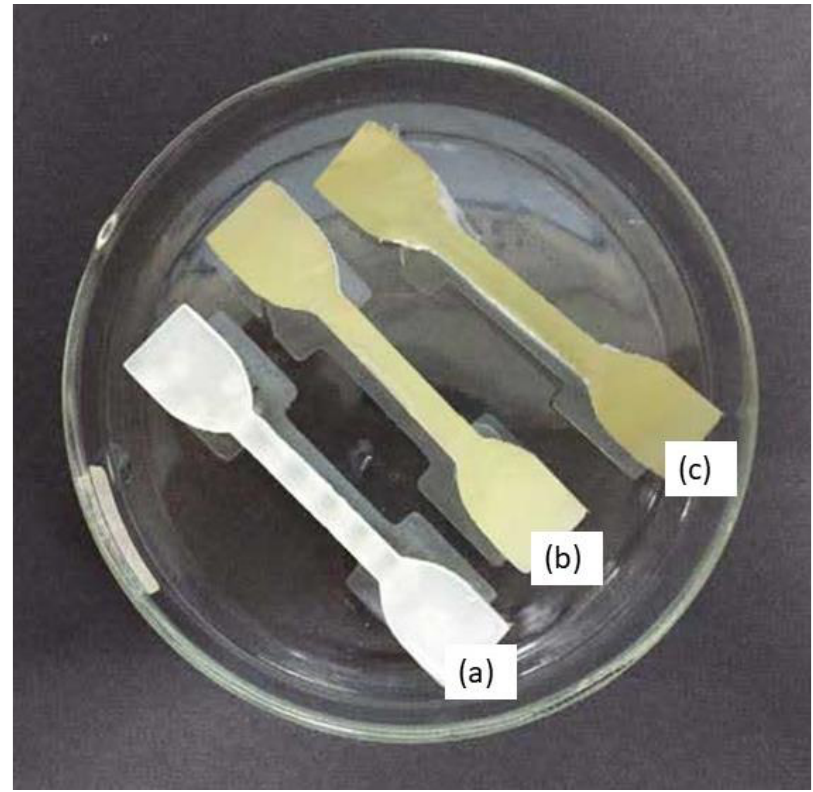
Figure 5. Dumbbell-shaped 3D-printed scaffold ( a ) 15% TPU + UHT; ( b ) 15% TPU+ UHT + 1% ϒ -Fe 2 O 3 ; ( c ) 15% TPU+ UHT + 5% ϒ -Fe 2 O 3 .